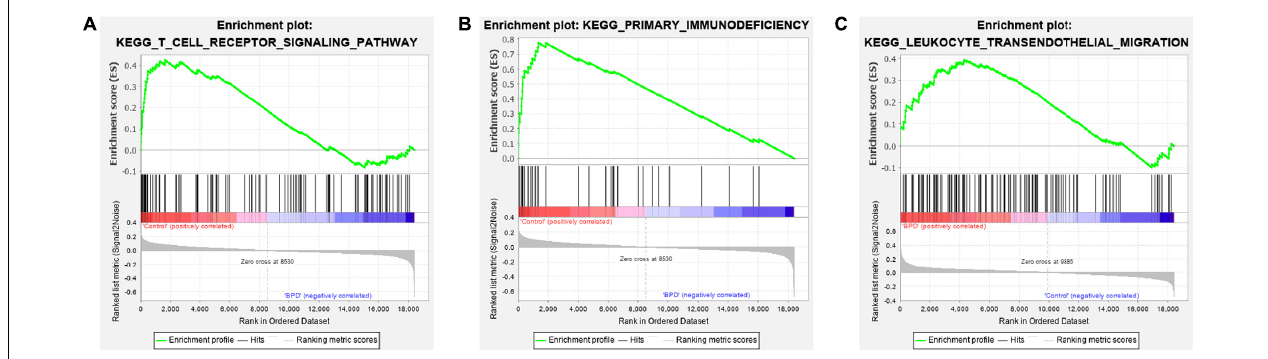
FIGURE 8 | Gene set enrichment analysis of real hub genes. (A) Enrichment result of ‘T cell receptor signaling pathway’ between the control group and the bronchopulmonary dysplasia (BPD) group. (B) Enrichment result of the term ‘primary immunodeficiency’ between the control group and the BPD group. (C) Enrichment result of ‘leukocyte transendothelial migration’ pathway between the control group and the BPD group.